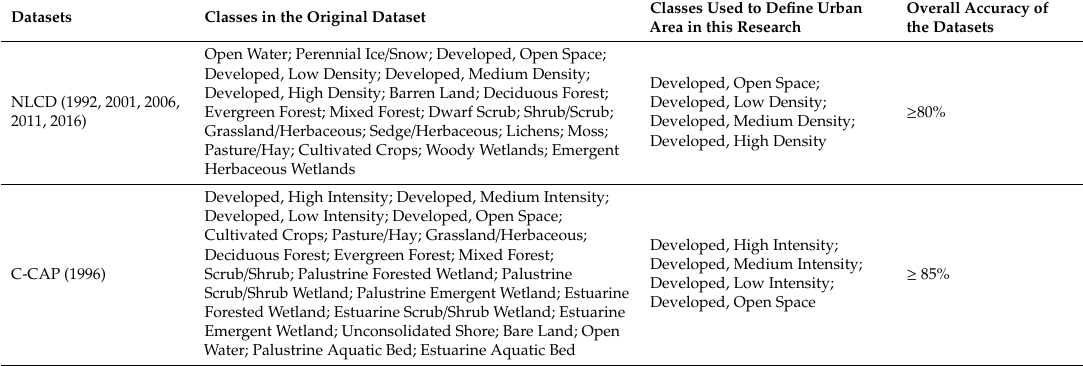
Table 1. Land cover classes in National Land Cover Datasets (NLCD) and Coastal Change Analysis Program (C-CAP) datasets and land covers used to define urban areas in this